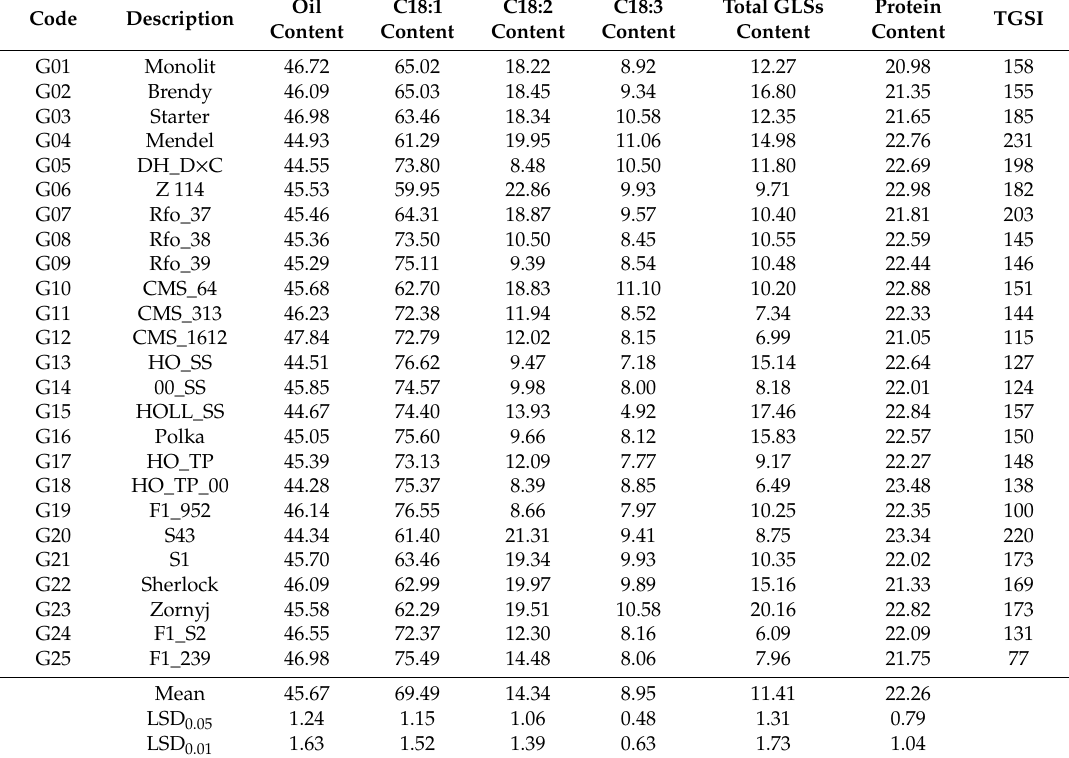
Table 2. Mean values of seed traits of 25 genotypes tested in field trials conducted in six environments. Oil, seed oil content (%); C18:1, oleic acid (%); C18:2, linoleic acid (%); C18:3, linolenic acid (%); GLS, total glucosinolates content ( µ mole g − 1 of seeds); protein content (%); TGSI, total genotype selection